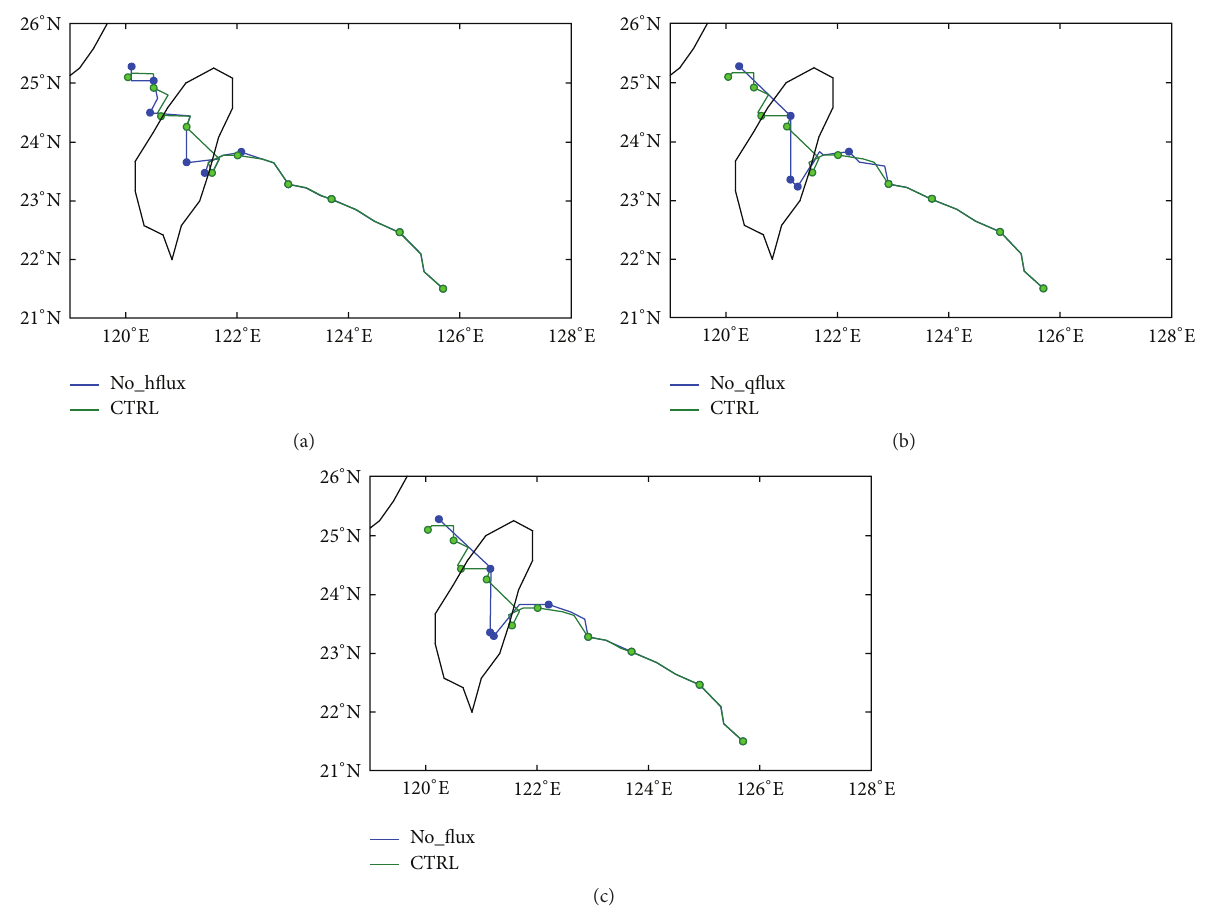
Figure 12: As in Figure 1, but for (a) No hflux, (b) No qflux, and (c) No